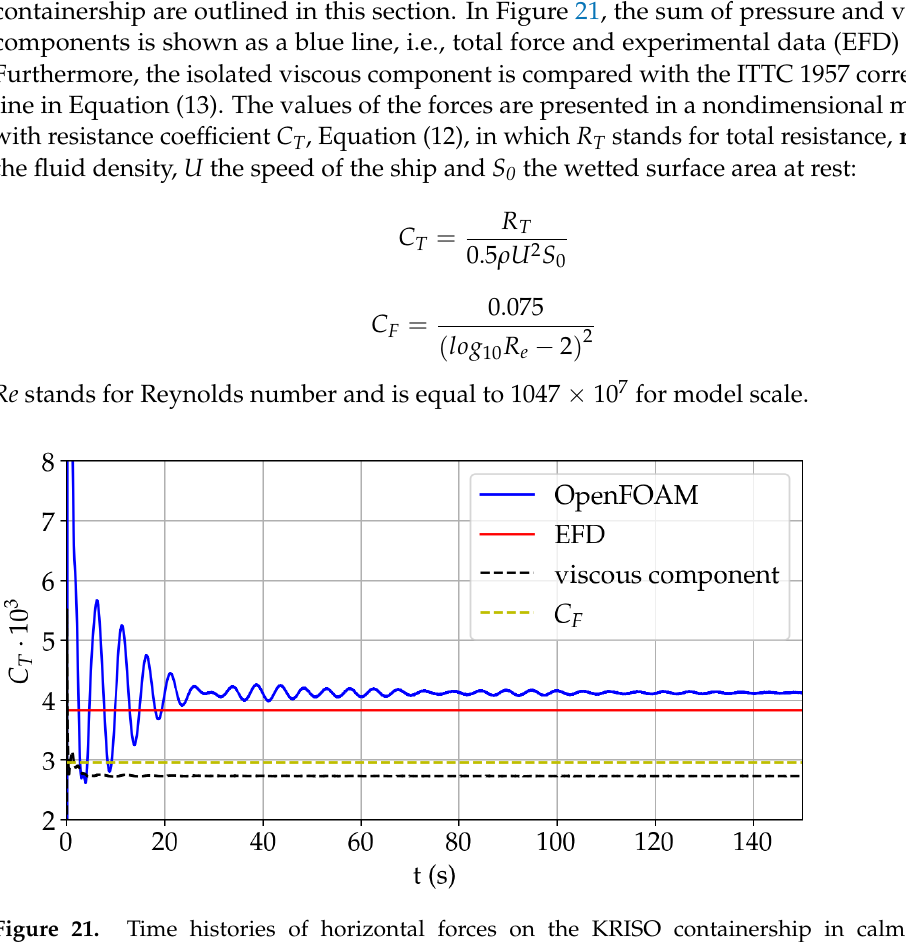
Figure 20. Time signals of pitch motion from experiment and numerics for H = 0.46 m for the 6750 TEU containership.